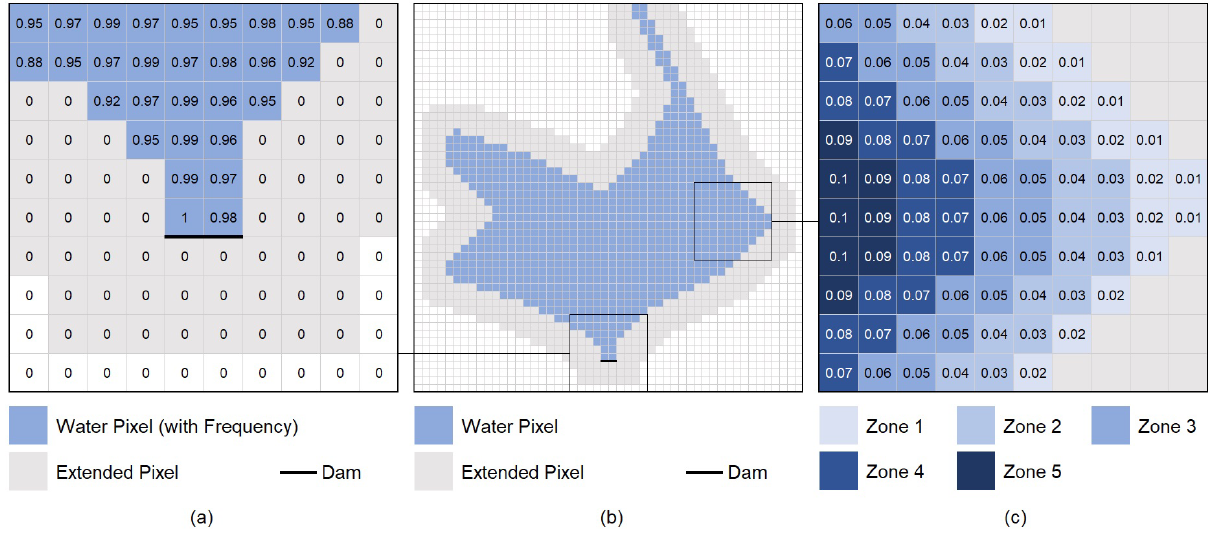
Hydrol. Earth Syst. Sci., 26, 2345–2364, 2022